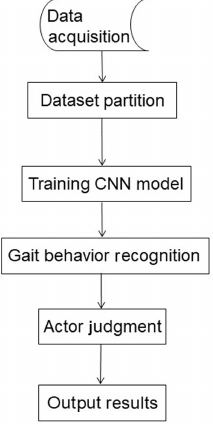
Fig. 5 Unimodal gait feature recognition